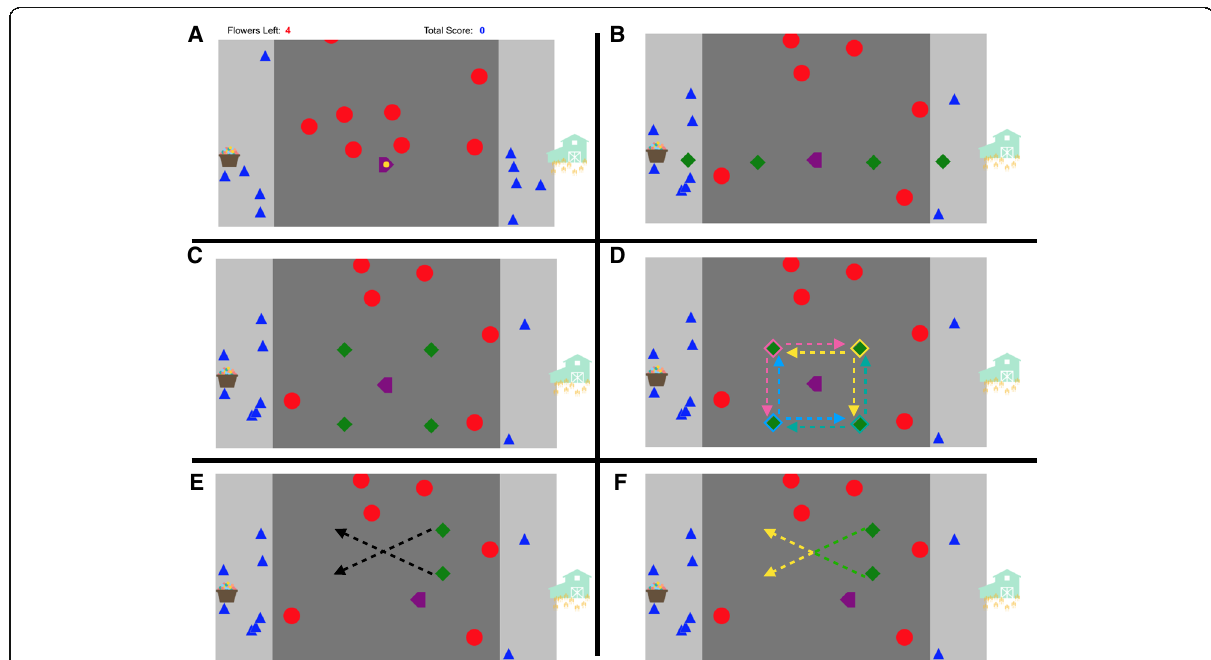
Fig. 1 Experimental setup. a A screenshot of the game, after a seed has been picked up. b The four possible unexpected object positions in Experiment 1. c The four possible unexpected object positions in Experiment 2. d The four possible starting positions of the unexpected objects in Experiment 3. The dotted lines show the possible trajectories and are color-coded to show which unexpected objects can take which trajectories. e The two starting positions and corresponding trajectories for the unexpected objects in Experiment 4. f The two starting positions and corresponding trajectories for the unexpected objects in Experiment 5. The color of the dotted lines corresponds to the color of the unexpected object at that point in its motion (the unexpected object could also start yellow and turn